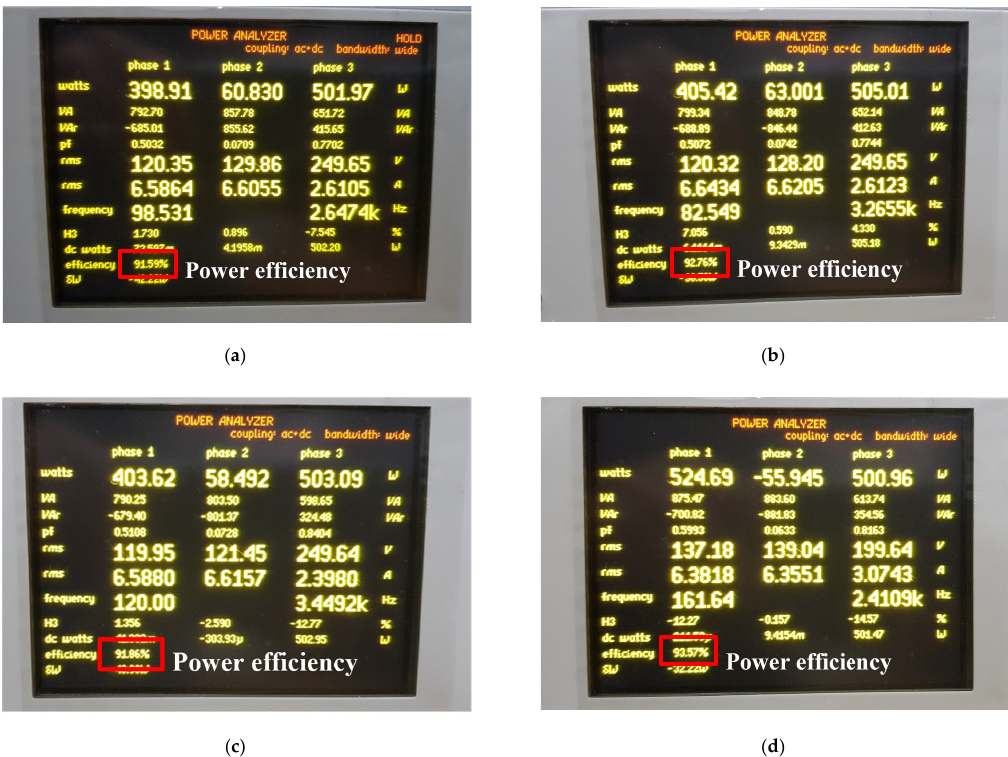
Figure 12. Experimental results of power efficiency. ( a ) the conventional method using one vector with T s = 125 μ s, ( b ) the conventional method using one vector with T s = 250 μ s, ( c ) the conventional method using two vectors with T s = 250 μ s, and ( d ) the proposed method with T s = 250 μ s.